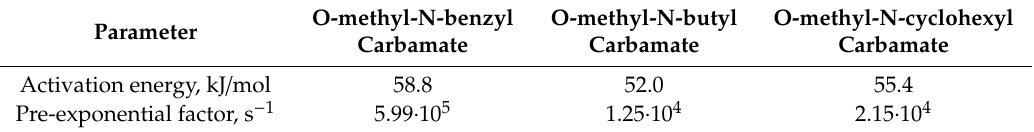
Table 6. Activation energies and pre-exponential factors of the studied